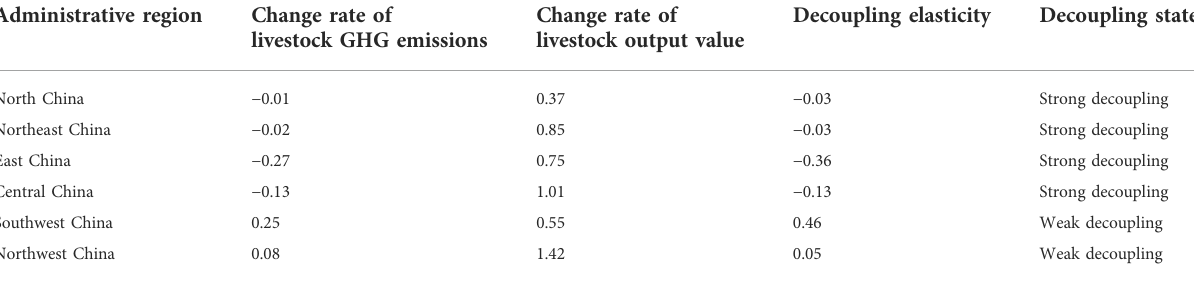
TABLE 6 The decoupling effects of livestock GHG emissions for regional CAGDMZ from 2010 to